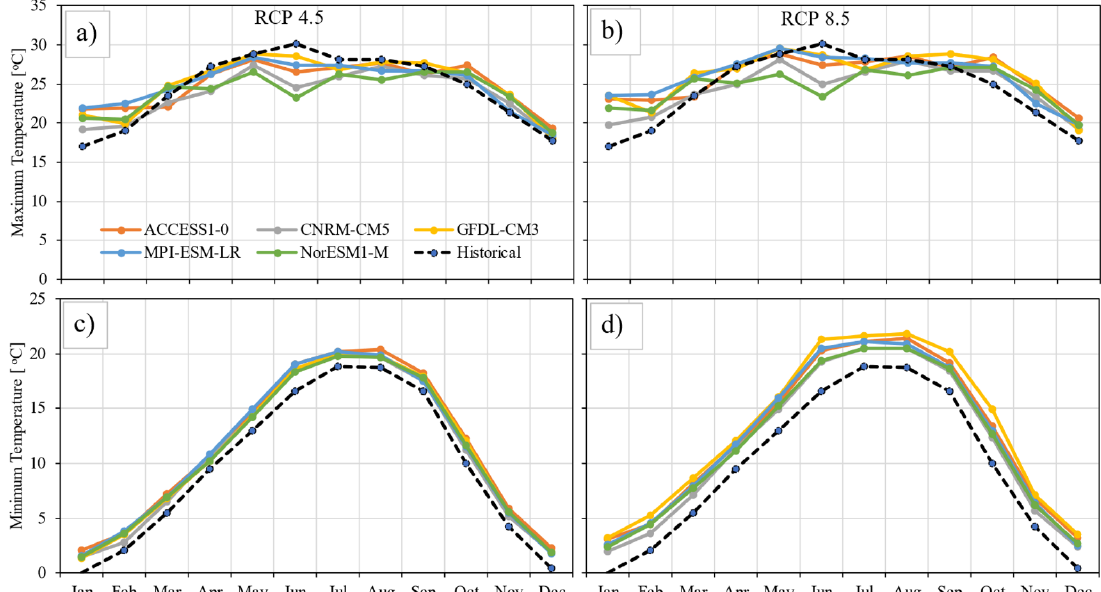
Figure 4. Monthly projection in maximum and minimum temperature averaged over two stations in the Thuli River Basin using multiple climate models under RCP 4.5 ( a , c ) and RCP 8.5 ( b , d ) emission scenarios. ( a , c ) show the projected precipitation and percentage change in precipitation amount under the RCP 4.5 emission scenario. ( b , d ) show the same under the RCP 8.5 emission scenario.